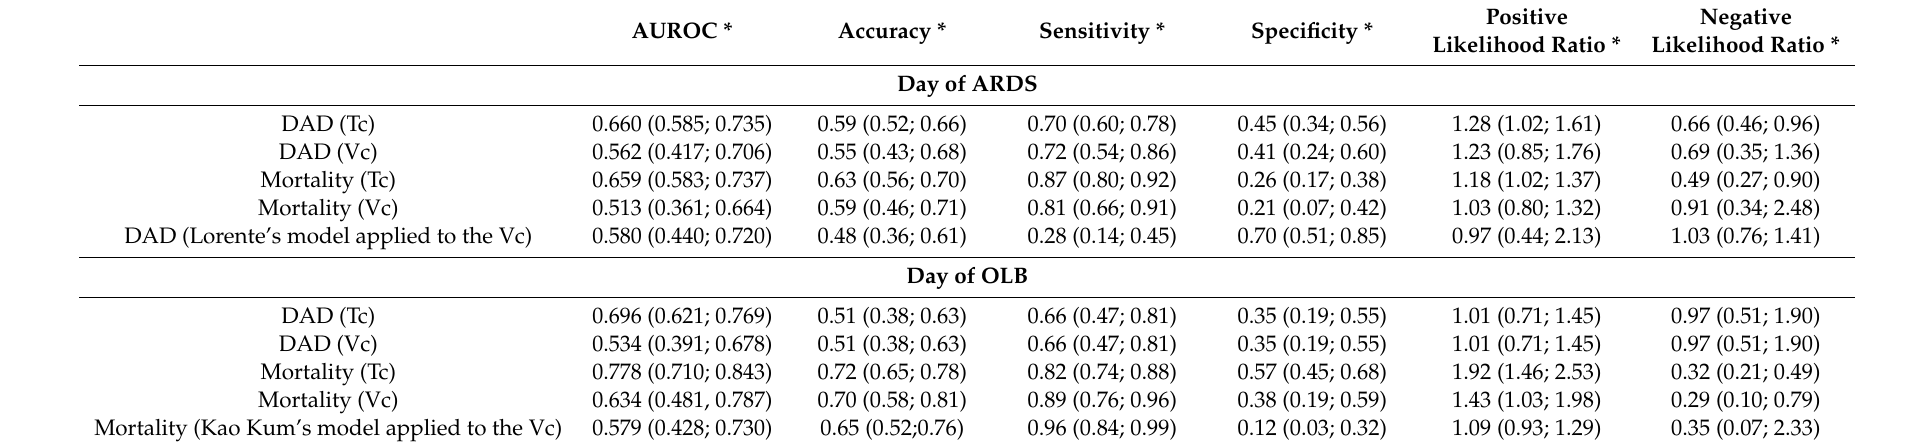
Table 6. Summary of model’s performance for predicting Di ff use Alveolar Damage and hospital mortality. AUROC